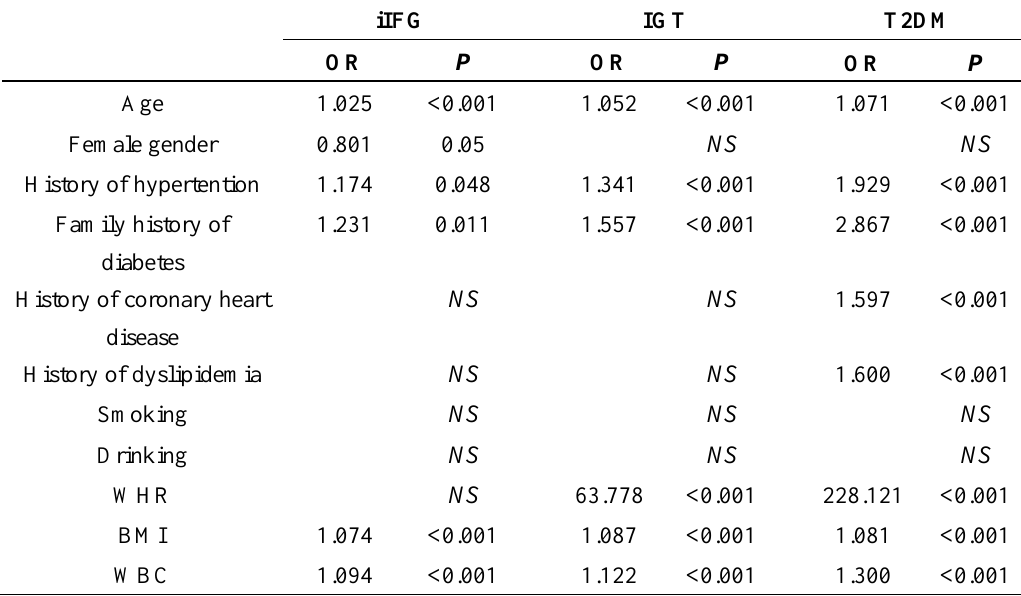
Table 2. Multinomial Logistic Regression Analysis with WBC Count and Possible Risk Factors as Independent Variables and Glycemic Status as Dependent Variables.